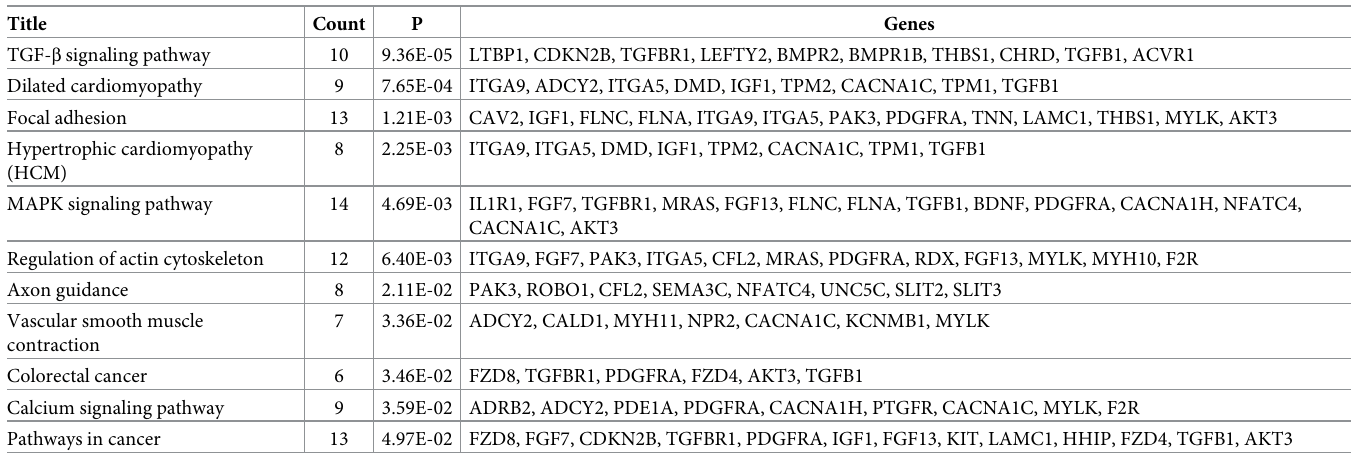
Table 3. Pathway analysis of the predicted target genes of